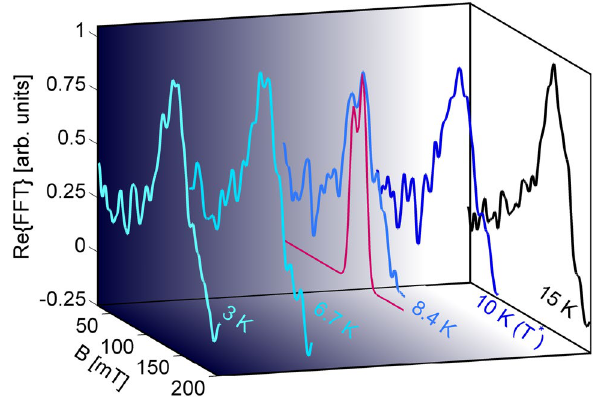
Figure 5. Normalized real-FT amplitude vs. B µ at selected temperatures below T SDW for the x = 0.05 case. The splitting of the main line below 10 K can be simulated numerically (red line) by considering a weighted superposition of islands with normally ordered (20%) and with tilted (80%) iron magnetic moments (0.56 µ B ). Note that, despite persisting down to T = 0 K, the line splitting is best observed at 8.4 K, since at